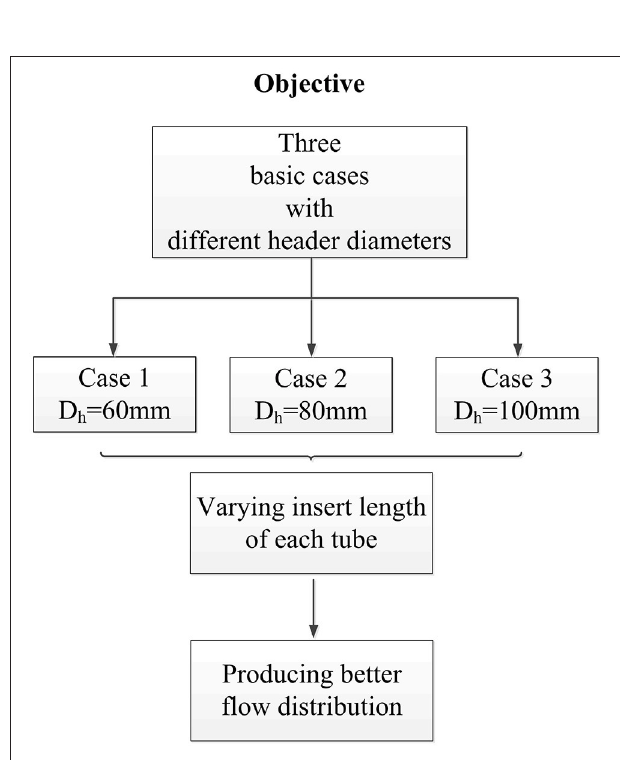
FIGURE 3 | The objective of the